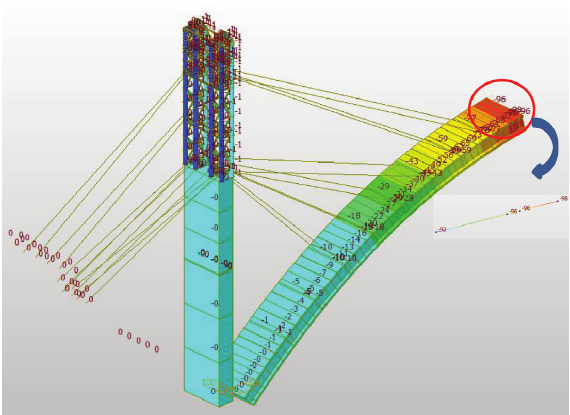
Figure 22: Vertical deformation when pouring concrete.